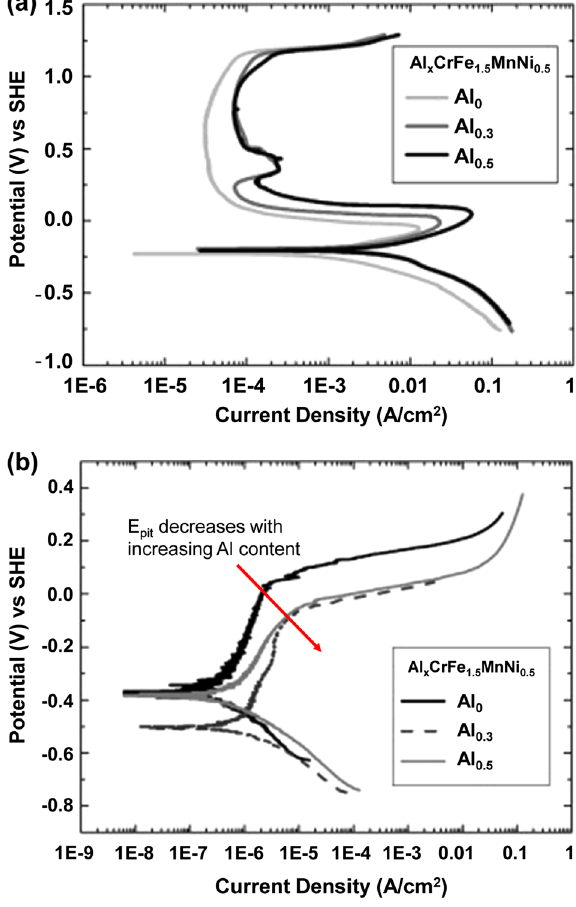
Fig. 2 a The effect of Al on the potentiodynamic polarisation response of the Al x CrFe 1.5 MnNi 0.5 system ( x = 0, 0.3, 0.5) in 0.5 M H 2 SO 4 (reprinted with permission from ref. 27). b A comparison of the potentiodynamic polarisation curves of the Al x CrFe 1.5 MnNi 0.5 system ( x = 0, 0.3, 0.5) in 1 M NaCl ( a, b reprinted from ref. 27 with permission from